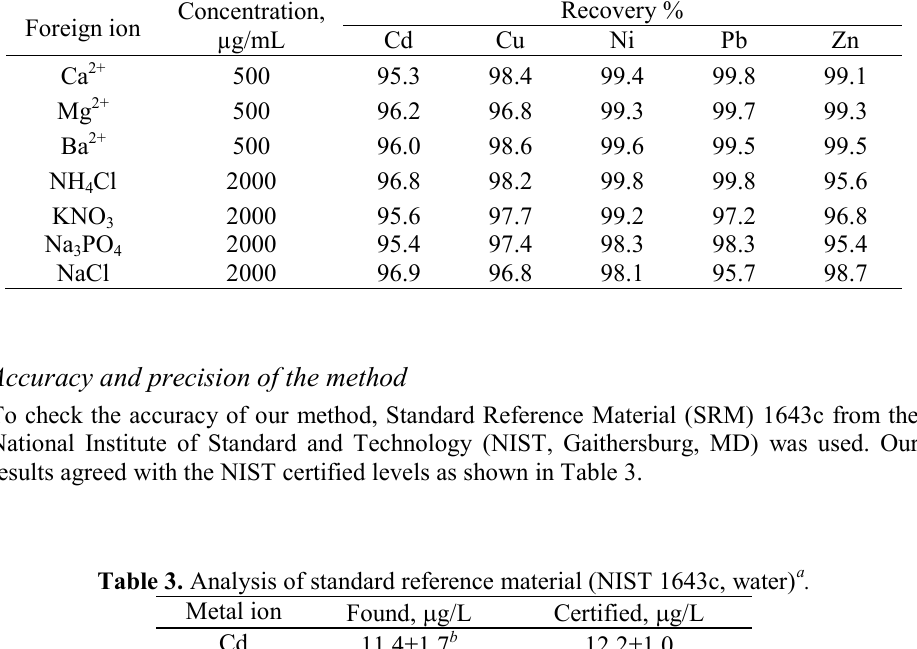
Table 2. Effect of foreign ions on percent recovery of 1.0 µg/mL metal ions. Foreign ion